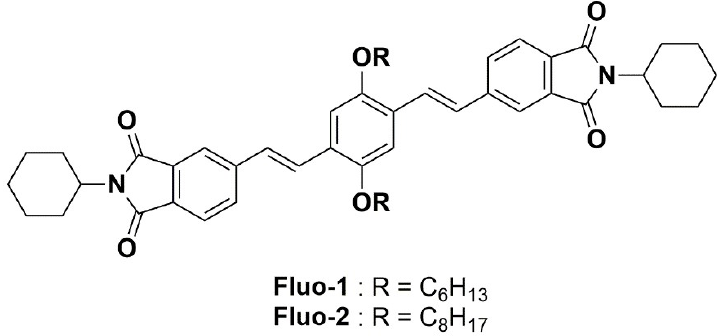
Figure 1. Chemical structures of Fluo-1 and Fluo-2 .